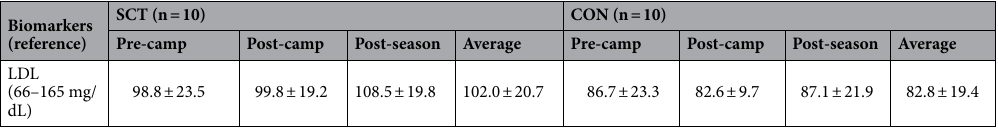
Table 3. Chemistry panel 26 profile of the two groups (SCT vs. CON) across the entire football season (pre- camp, post-camp, and post-season). Data presented as mean ± SD. BUN blood urine nitrogen, CPK creatine kinase, LDH lactate dehydrogenase, AST aspartate amino transferase, ALT alanine amino transferase, ALK alkaline phosphate, GGT gamma-glutamyl transferase. a Significant differences in SCT compared to CON. b Significant difference in SCT compared to CON at pre-camp. c Significant difference in SCT compared to